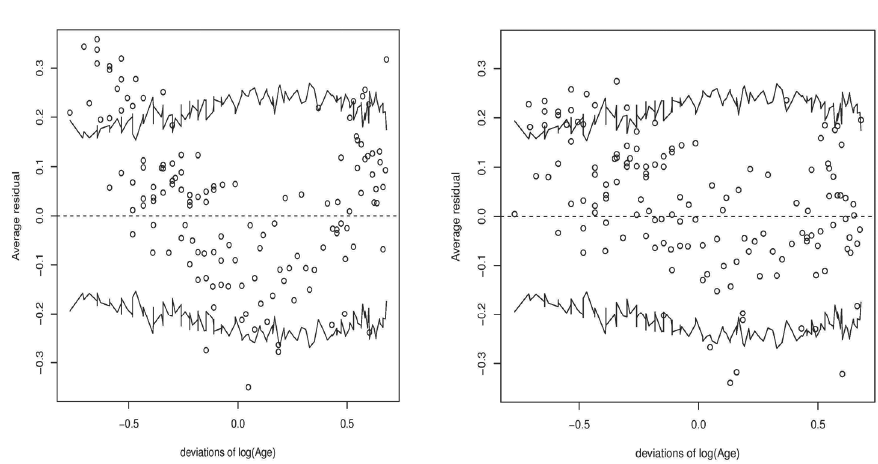
Figure 1 – Binned residuals for (cid:91) (cid:3) parameter with covariates Age (left panel) and Age 2 (right